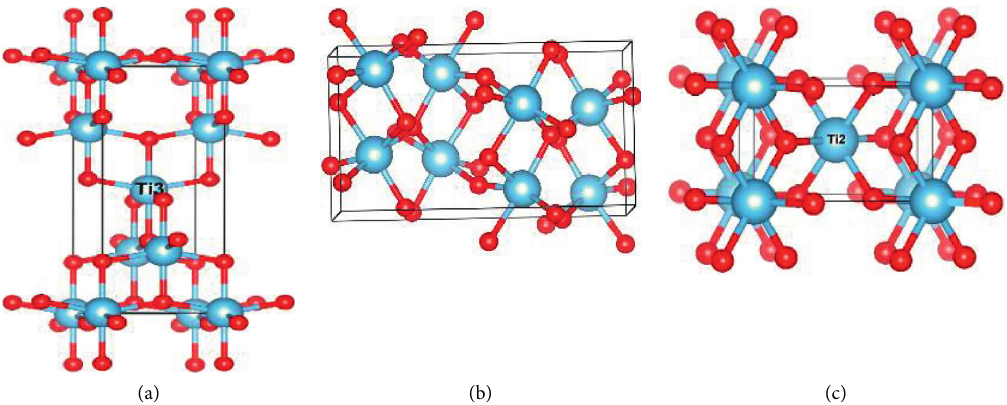
Figure 1: Bulk unit cells for (a) 12 atom tetragonal anatase (space group 141/amd), (b) 24 atom orthohormbic brookite (space group pbca), and (c) 6 atom tetragonal rutile (space group P42/mnm).